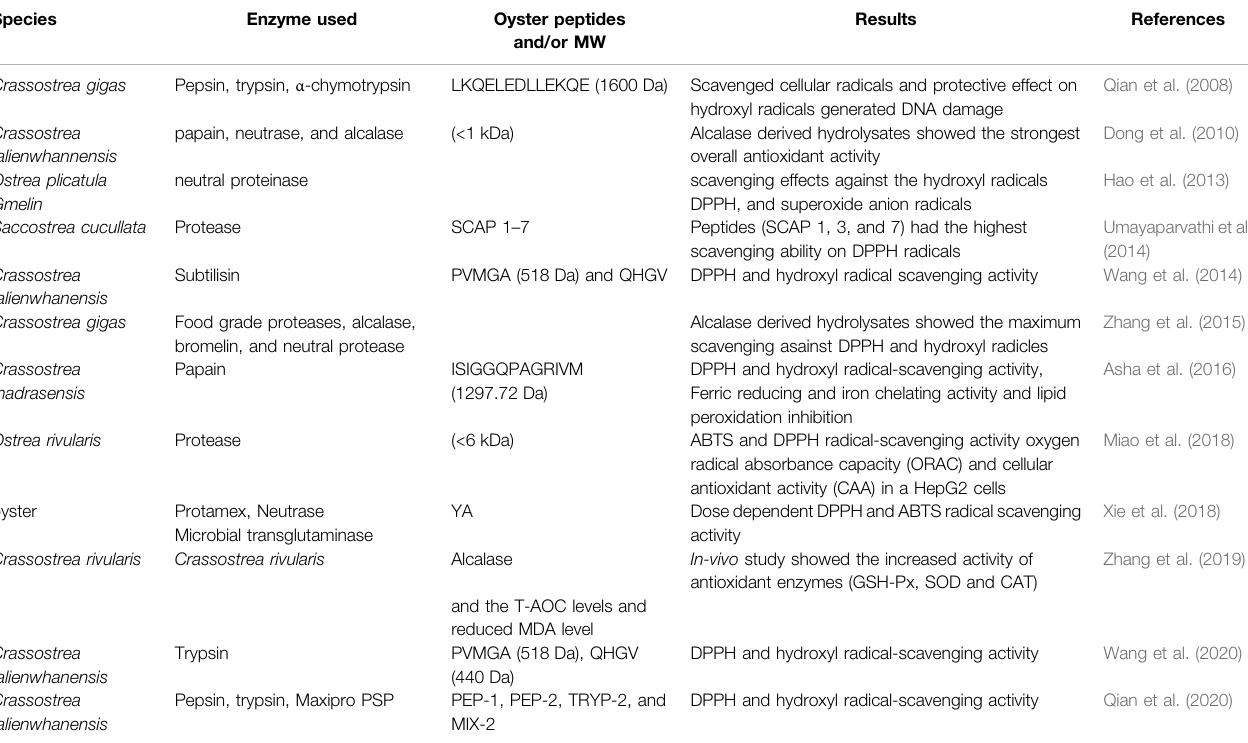
TABLE 2 | Antioxidant peptides derived from oyster whole tissue.